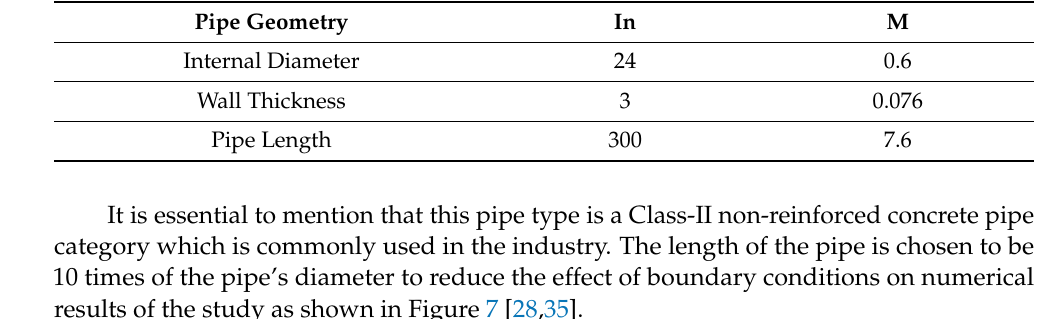
Table 7. Pipe geometry in